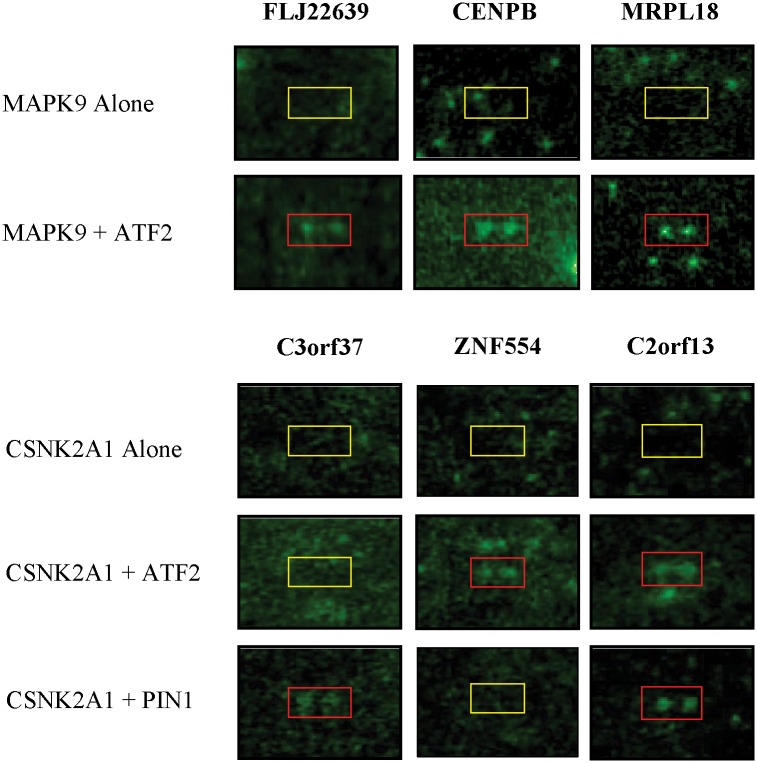
Experimental validations for CSNK2A1 and MAPK9.A human proteome microarray, comprised of 17,000 individually purified human proteins in full-length, was used to perform phosphorylation reactions with CKII (CSNK2A1) and JNK2 (MAPK9) in the presence or absence of their predicted scaffold proteins, ATF2 and PIN1. Phosphorylation signals were detected by exposure of the human proteome microarrays to X-ray film. Positive hits in red boxes were identified by visual inspection.